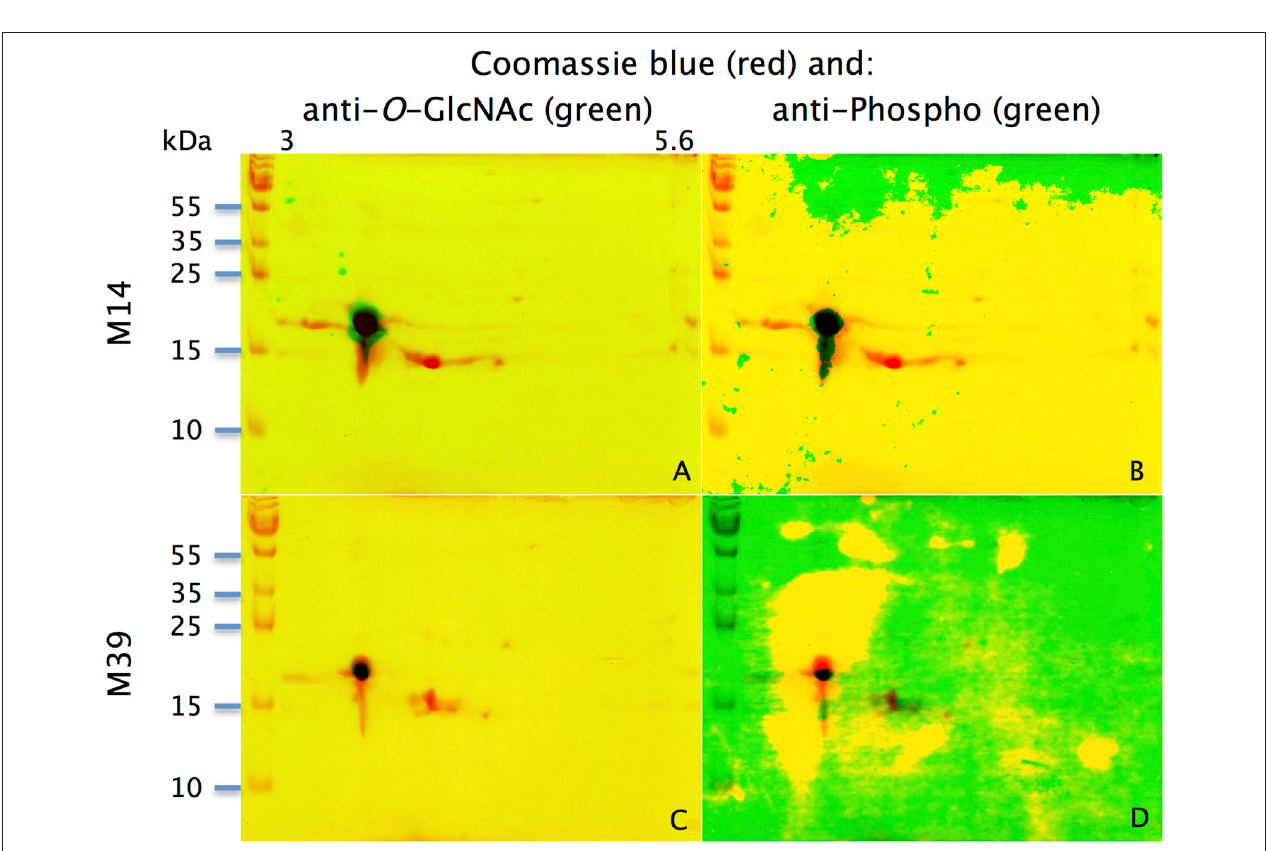
FIGURE 3 | Identification of potential phosphorylation and O -GlcNAcylation of M14 (A,B) and M39 (C,D) protein spots. M14: (A,C) represent the merging of Coomassie-blue staining (red) and western-blot with anti- O -GlcNAc (CTD110.6, green) for individuals M14 and M39, respectively. (B,D) represent the merging of Coomassie-blue staining (red) and western-blot with anti-phosphoS/Y/T (green) for M14 and M39, respectively. X-axis: pI, Y-axis: molecular weight